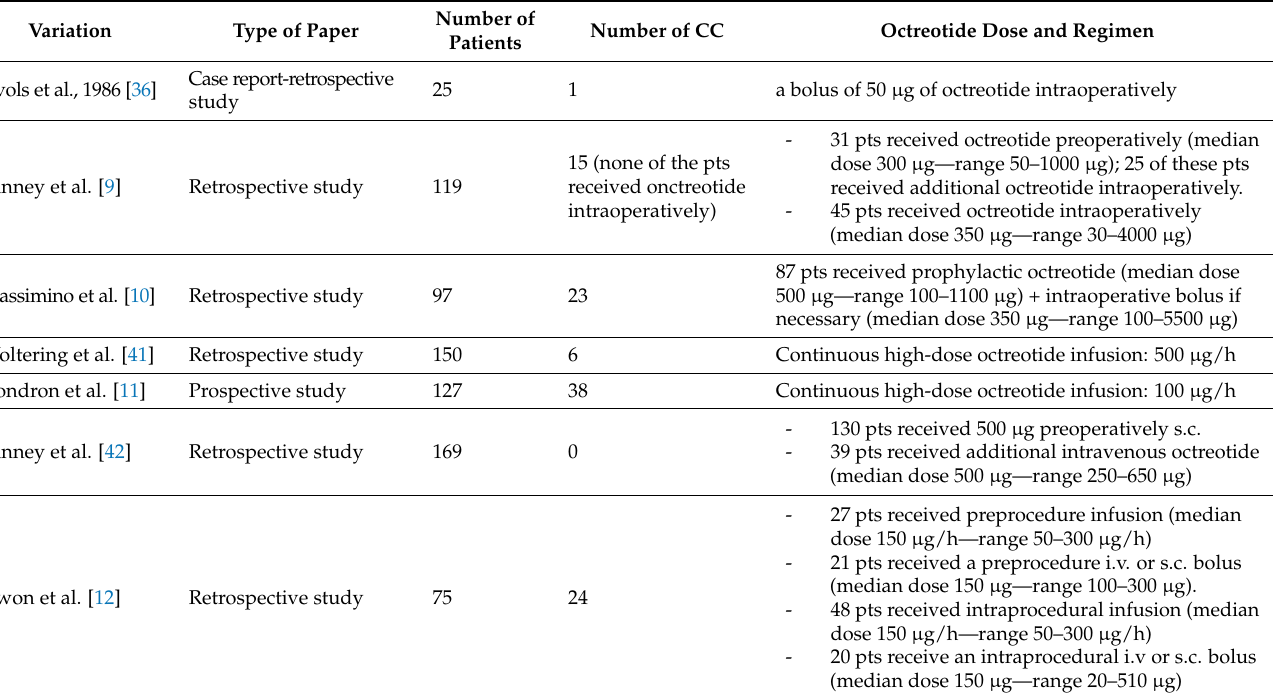
Table 3. Articles assessing the impact of octreotide in